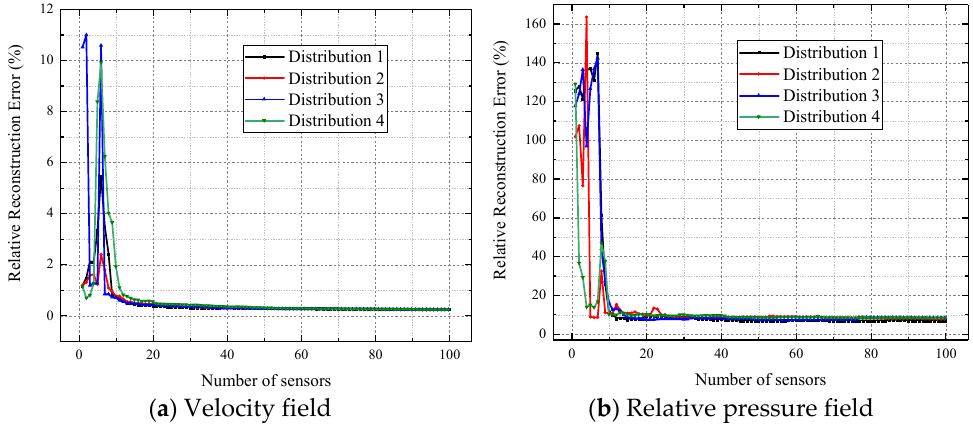
Figure 16. Relative reconstruction error (%) for different number of sensors with four distributions.